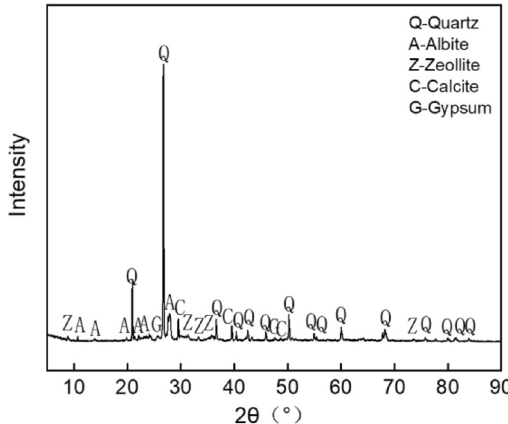
Figure 11. XRD pattern of ordinary sintered red brick.